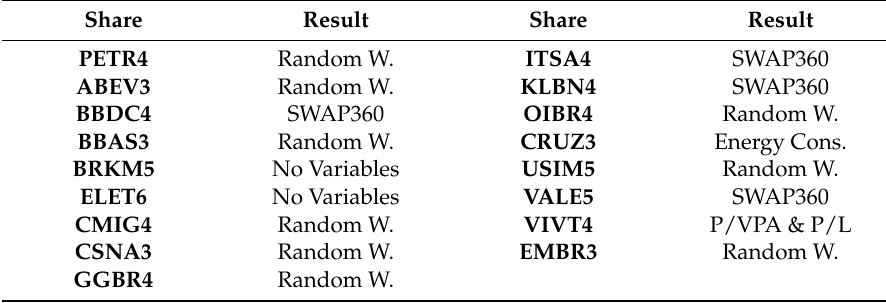
Table 3. Result of the model